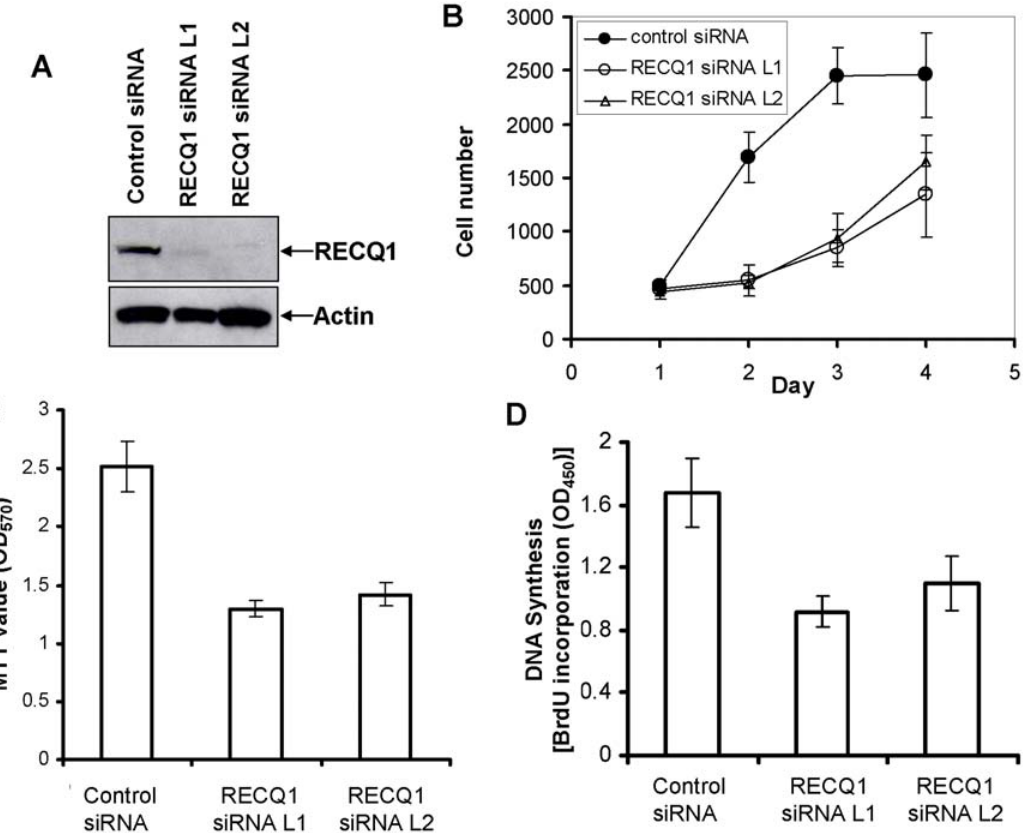
Figure 3. RECQ1-depleted cells show reduced cellular proliferation. Panel A , Small interfering RNA inhibition of RECQ1. Whole cell extracts from HeLa cells that had been transfected with control or RECQ1 siRNA (oligonucleotide L1 or L2) were subjected to Western blotting with RECQ1 or Actin antibodies (as a loading control). Panel B , Proliferation of control or RECQ1 siRNA treated cells as determined by CyQuant assay at indicated time points after transfection. Panel C , MTT assay of in vitro proliferation of control or RECQ1-siRNA transfected cells. Panel D , Colorimetric BrdU cell proliferation ELISA of control or RECQ1 siRNA treated HeLa cells. Results are taken from three independent experiments and proliferation is represented as the mean 6 standard deviation (SD).